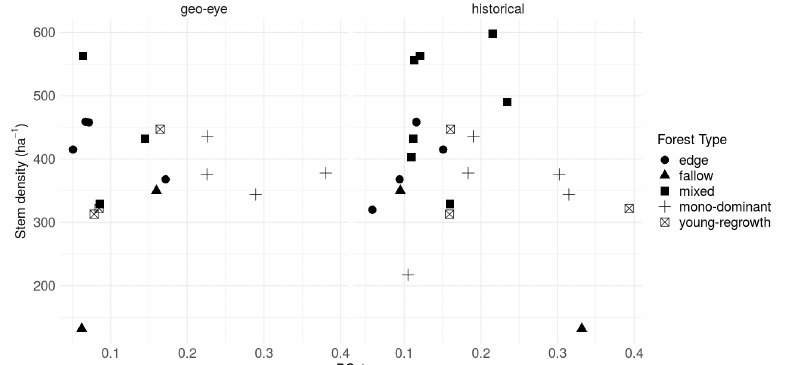
Figure A6. Scatterplot comparing stem density (per ha) and the first principal component of the FOTO analysis for contemporary Geo-Eye ( left ) and the historical orthomosaic ( right ) data. Different forest types are plotted using closed circles, closed triangles, closed squares and this for fallow, mixed mon-dominant and young-regrowth forests,